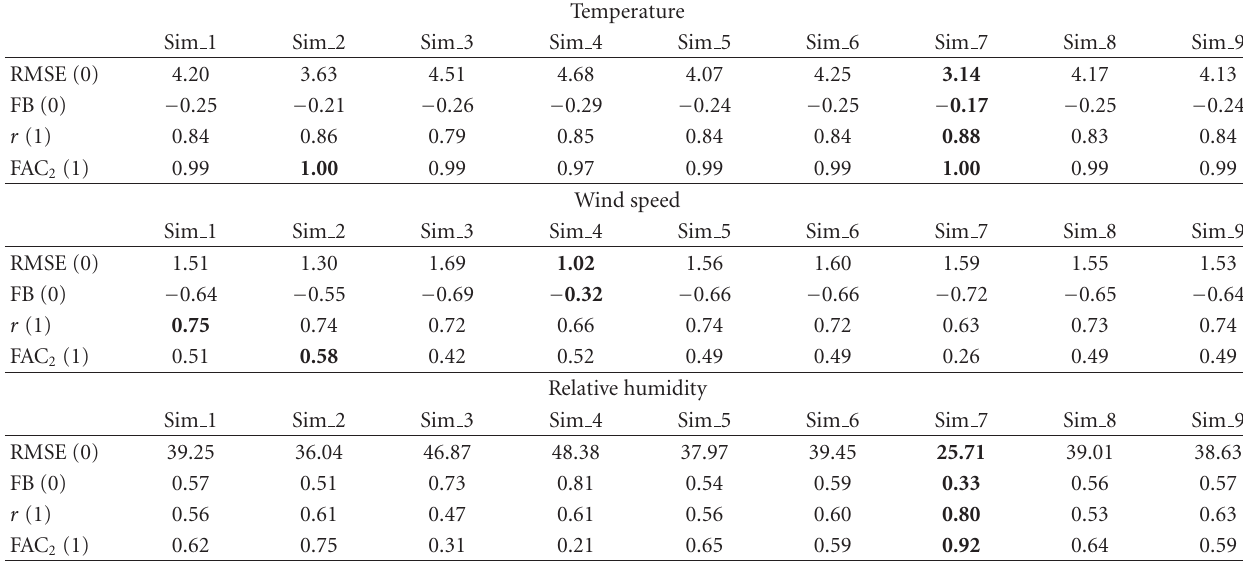
Table 5: Statistical evaluation of winter simulations, station